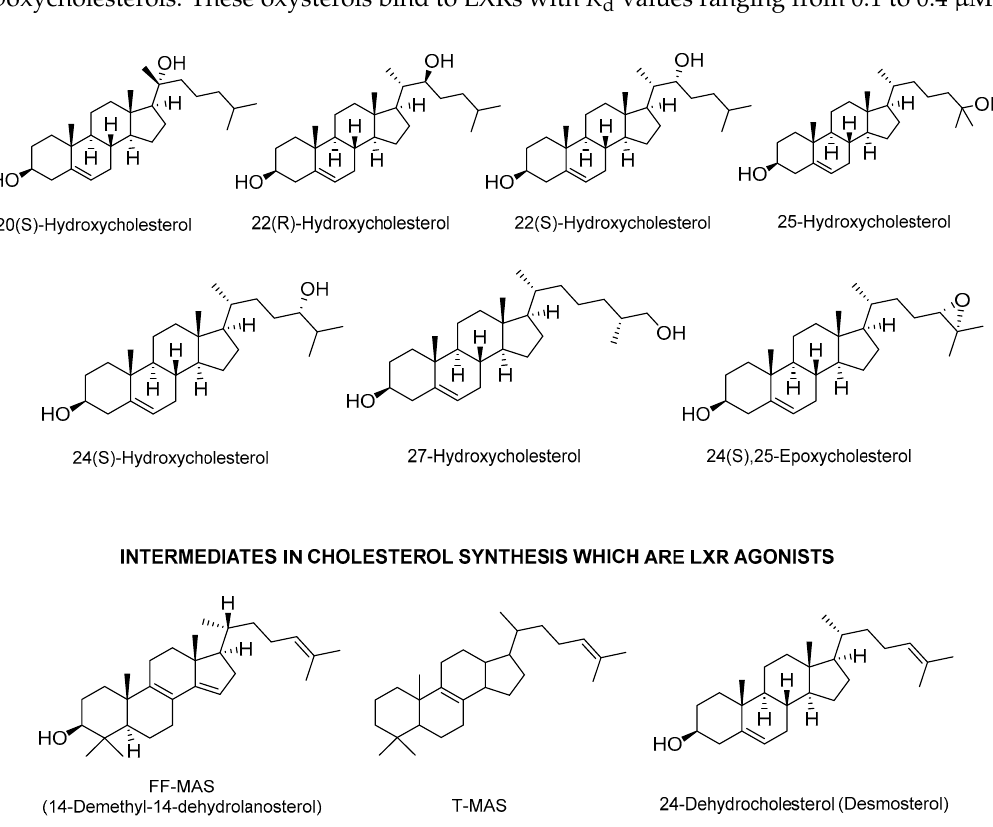
Figure 2. Representative endogenous ligands that activate LXRs.